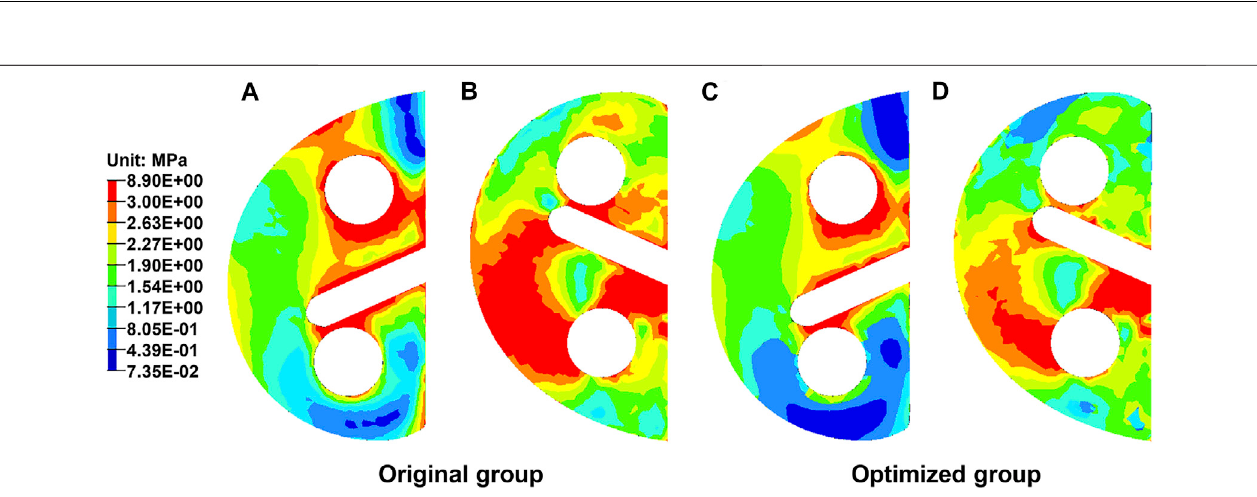
FIGURE6| Distribution ofthevonMises stressin themetal blockaugmentation fromtop andbottom views. (A) Originalblockfrom thetopview. (B) Originalblock from the bottom view. (C) Optimized block from the top view. (D) Optimized block from the bottom view.